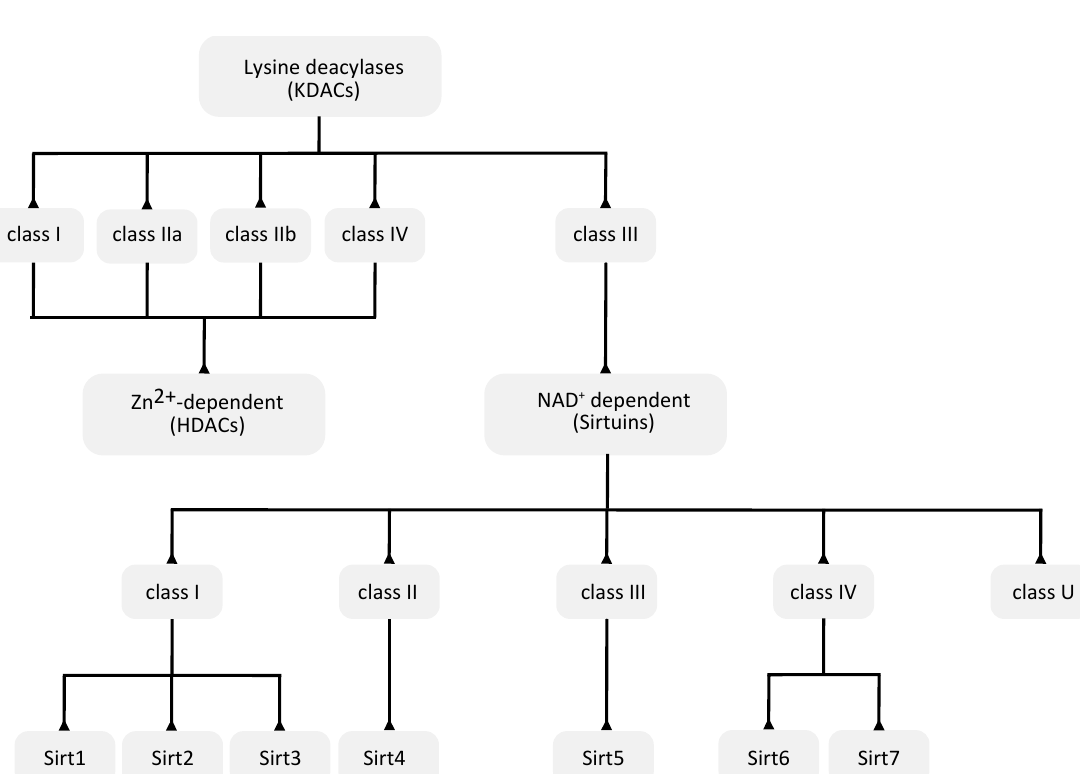
Figure 2. Classification of different lysine deacylases (KDACs) based on their phylogenetic conservation and/or sequence similarities.